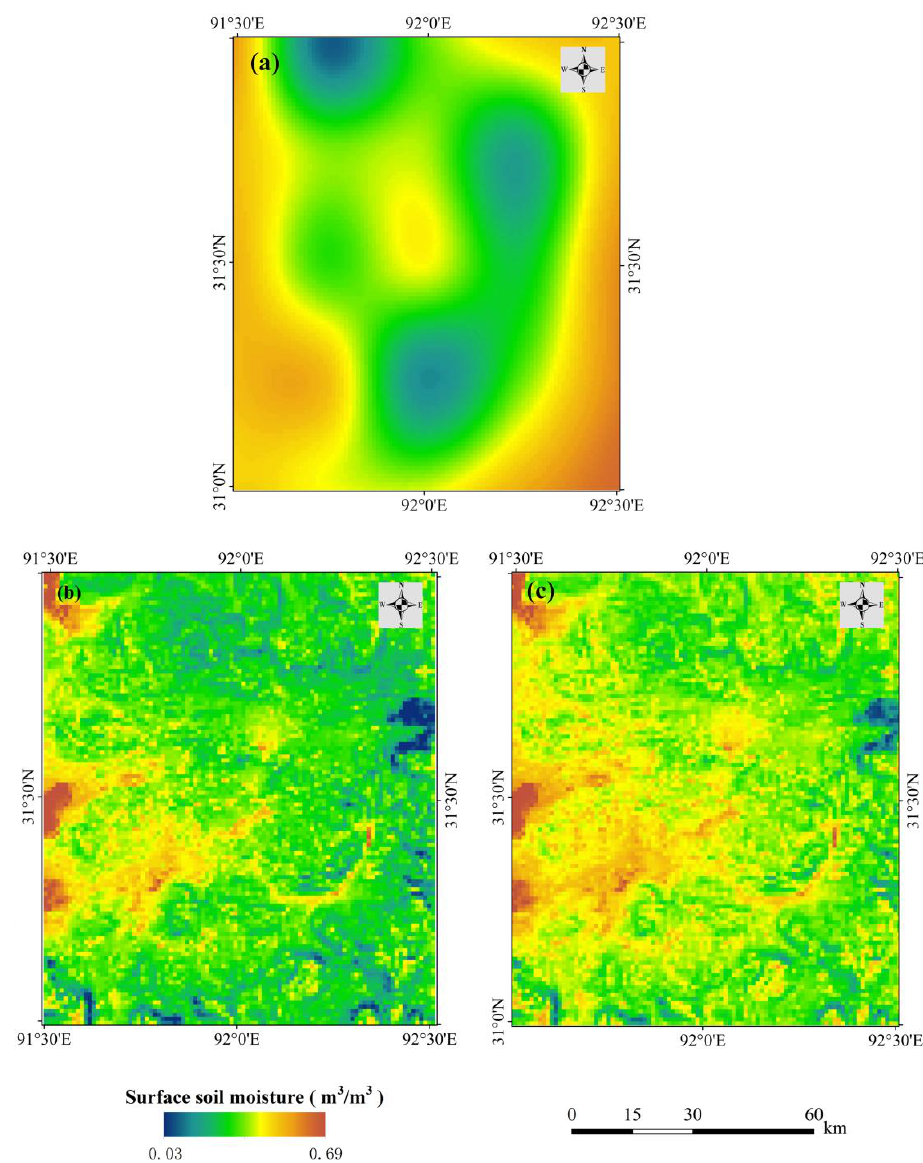
Figure 4. Surface soil moisture on 24 July 2011 in 1 km pixel size: ( a ) AMSR-E data resampled to MODIS scale; ( b ) the retrieved MODIS surface soil moisture; ( c ) the corrected MODIS surface soil moisture.